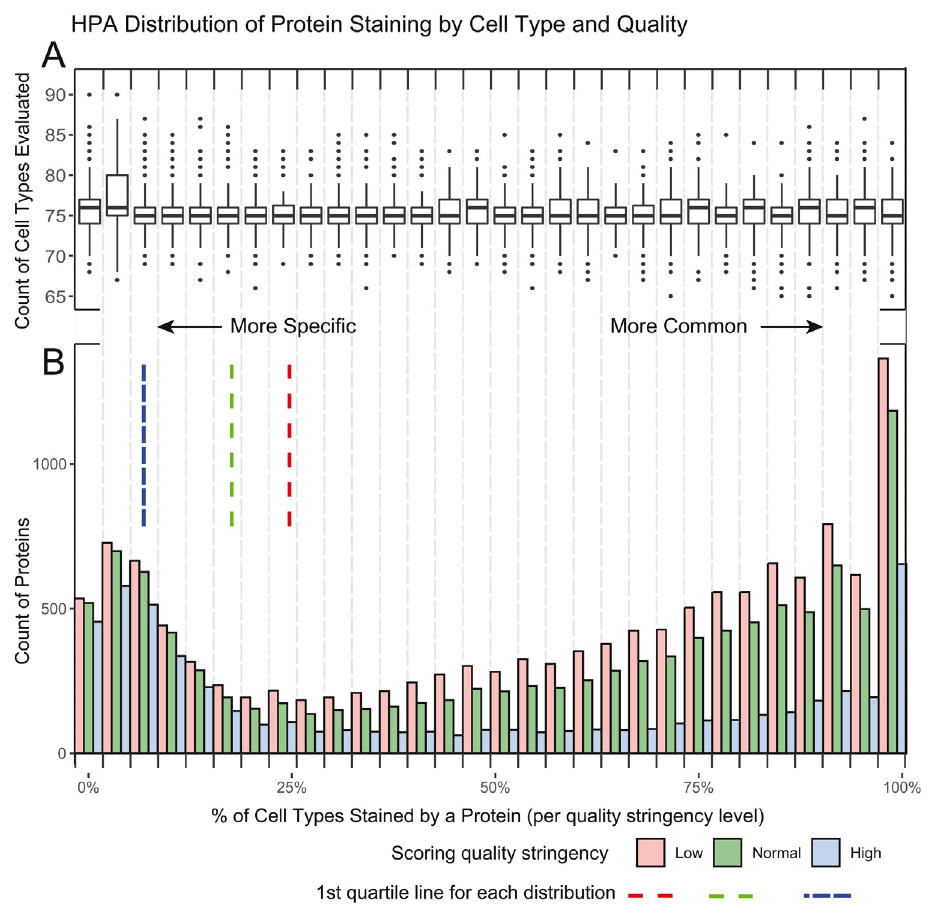
Figure 2. HPA distribution of protein staining by cell type and quality. A . A boxplot of the number of cell types evaluated per protein in each of the 30 histogram bins. The overall median of cell types is 75 proteins with the 1 st and 3 rd quartile being 74 and 77 proteins respectively. This illustrates that tissue enrichment of a protein is not an artifact of how often a protein is scored, as there is a similar level of testing across bins. B . A histogram demonstrating the percent of positive staining cells per protein. Three quality stringencies are given. The 1 st quartile lines demonstrate the specificity cut off of the distribution used at each stringency level. As expected, the number of proteins in the 1 st quartile increase with lower stringency. More commonly detected genes are more greatly affected by stringency when compared to rarely detected genes. There also appear to be a larger number of specific proteins (10%) than there are of semi-specific proteins (25%) in HPA, as the distribution from common to specific decreases before peaking